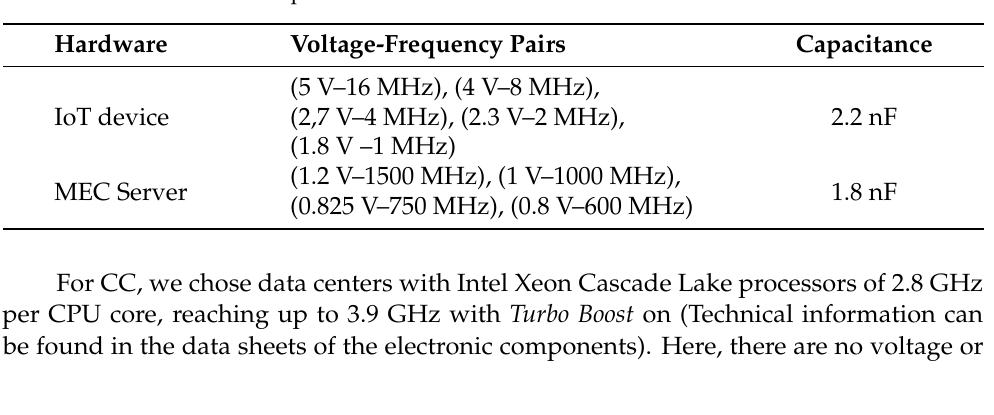
Table 3. Device variables for power